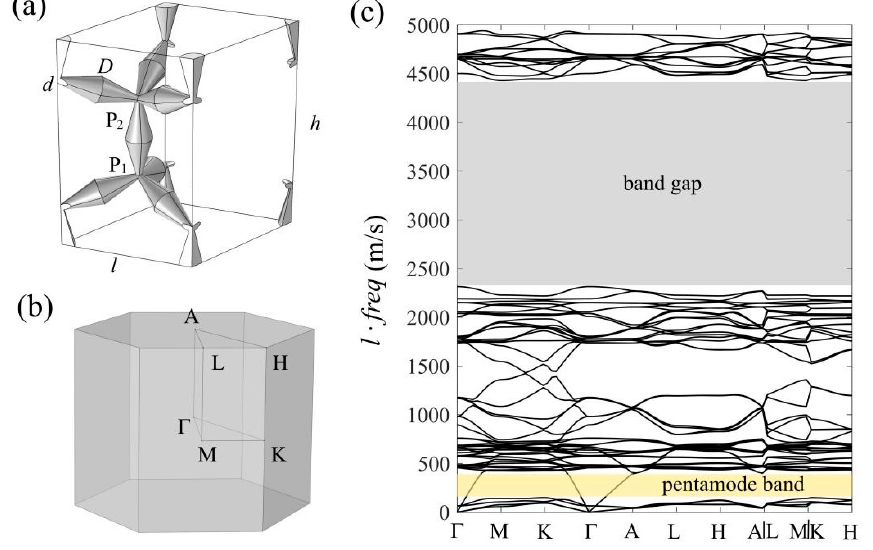
Figure 1. Elastic metamaterials with hexagonal unit cells: ( a ) primitive cell; ( b ) Brillouin zone; ( c ) band structures around the boundaries of the irreducible Brillouin zone.